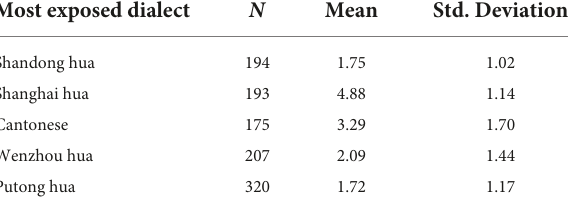
TABLE 3 Proficiency by